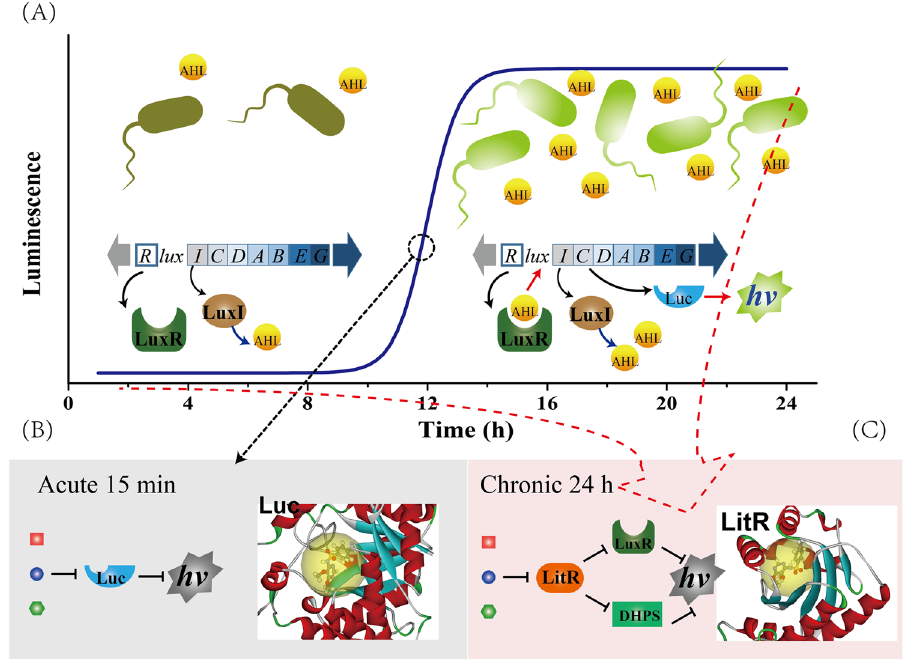
Figure 3. Mechanisms for the acute and chronic toxicity of individual chemicals. ( A ) The luminescence curves of V . fischeri during 0–24 h. From 0–10 h, there was no QS communication among the bacteria, since the bacteria and the AIs were at low concentrations. After 10 h, the AIs around the bacteria achieved the threshold concentration and triggered on the bacterial QS communication. ( B ) In the acute test, the antibiotics primarily target the luciferase (Luc) to inhibit the bioluminescence. ( C ) In the chronic test, the antibiotics acted on LitR to inhibit the QS communication and thereby the